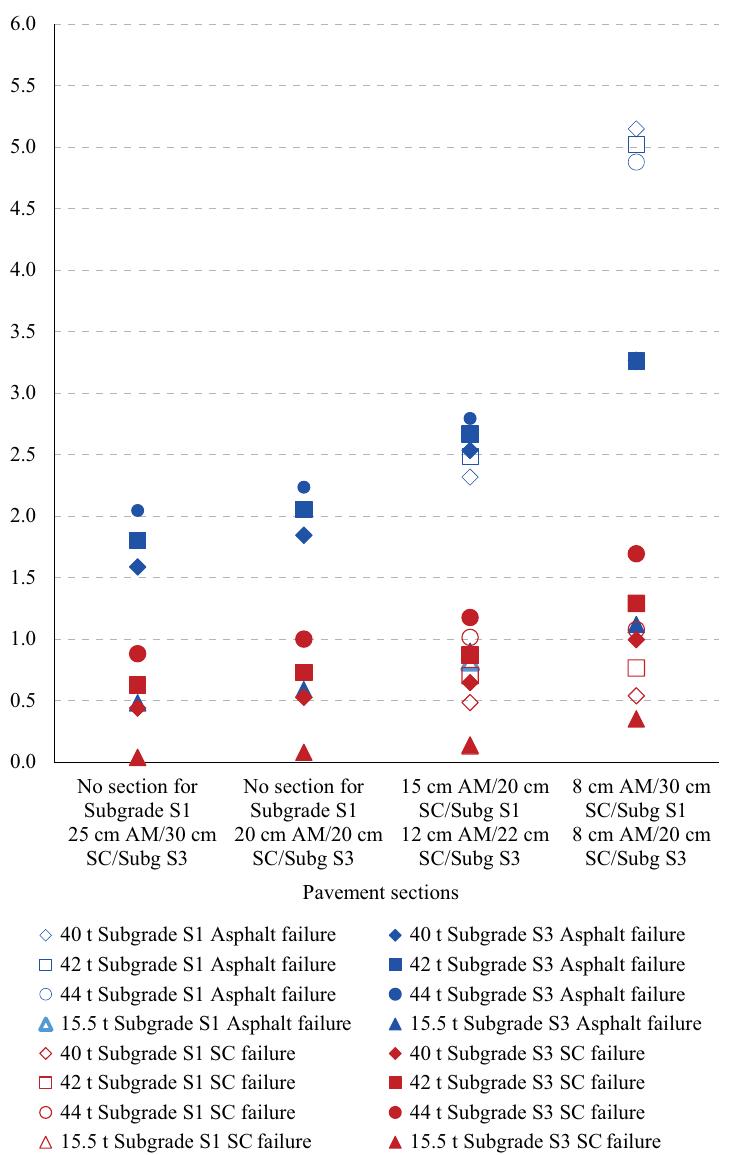
Figure 6. Aggressiveness coefficient for a heavy vehicle on